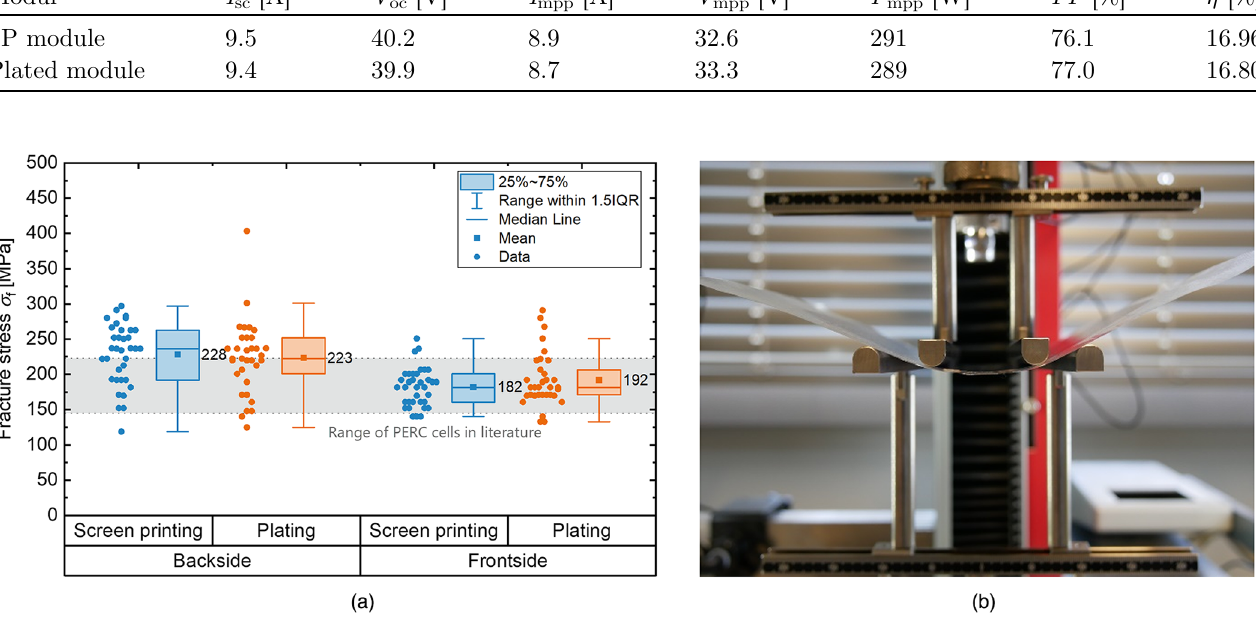
Fig. 5. Measured fracture stress of the front and rear side of bifacial TOPCon solar cells with either screen printed AgAl(front side)/ Ag(rear side) or plated Ni/Cu/Ag metal contacts (a). The grey area in (a) represents a typical fracture stress regime of PERC solar cells from literature [11]. The right image (b) shows the 4-point bending test of a bifacially plated TOPCon solar cell.